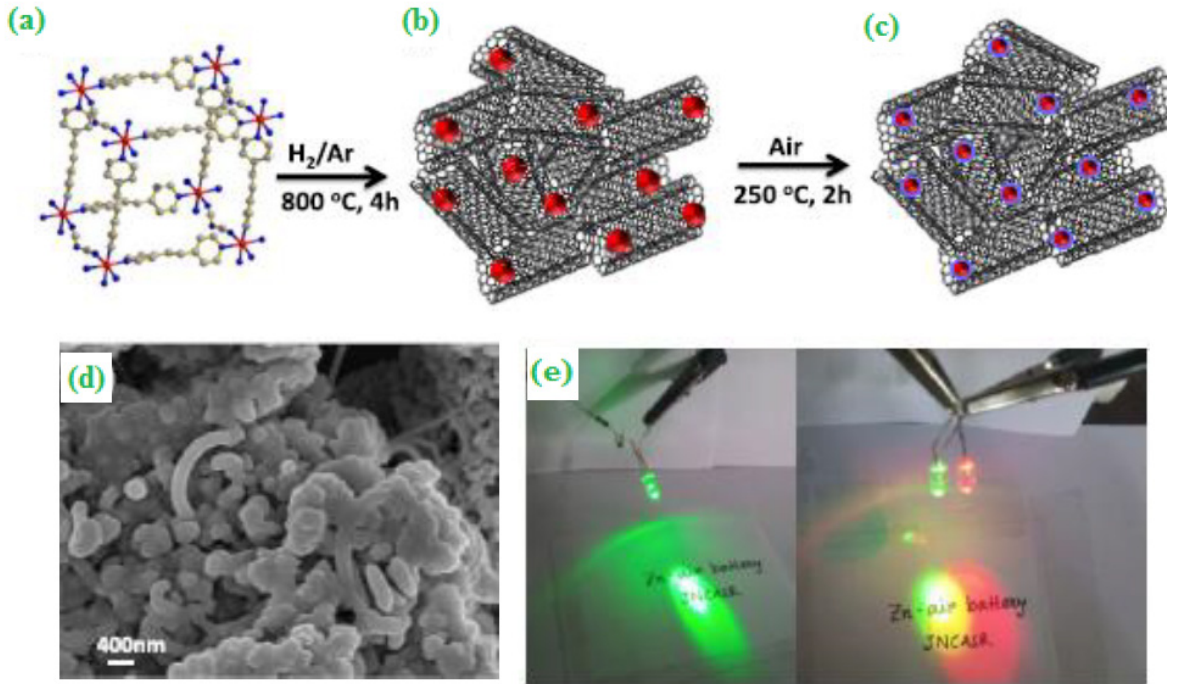
Figure 5. ( a ) Crystal structure of {[Co(bpe) 2 (N(CN) 2 )]·(N(CN) 2 )·(5H 2 O)} n MOF (CoMOF-1), ( b , c ) Car- bonization process and the core Co/NCNT obtained as the intermediate followed by the calcination leading to the formation of Co 3 O 4 @Co/NCNT, ( d ) FE-SEM image of Co 3 O 4 @Co/NCNT, and ( e ) Op- tical image showing brightly lit LEDs. Copyright 2020 by American Chemical Society [52].